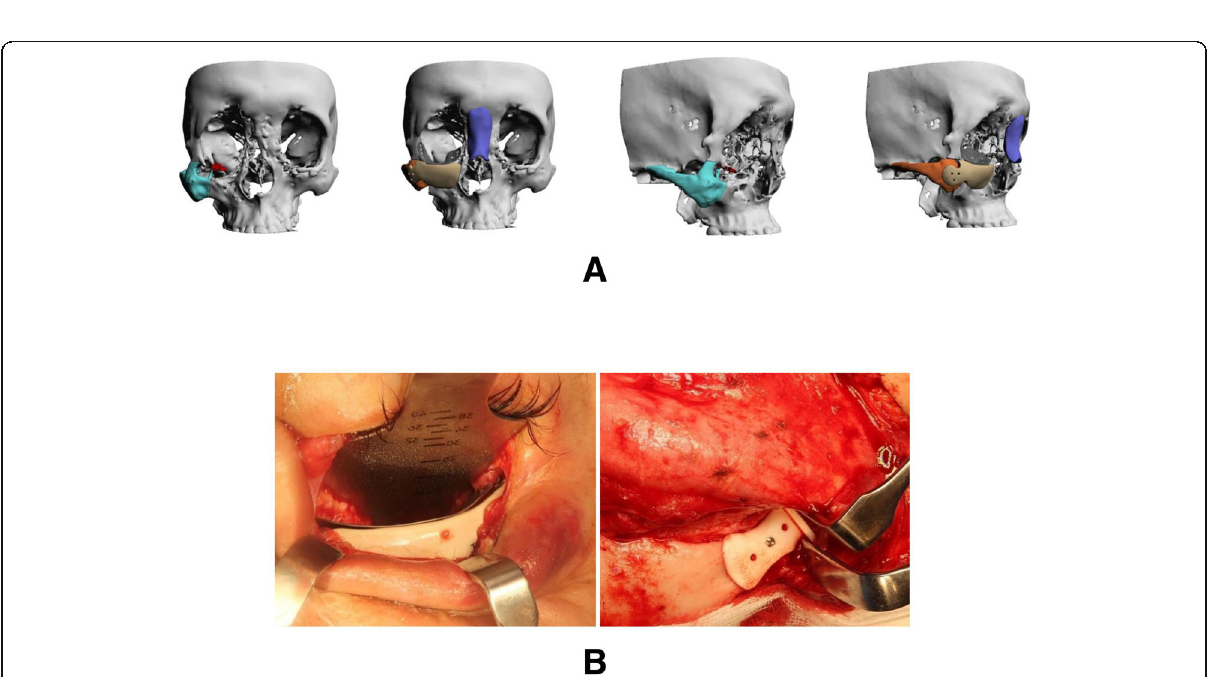
Fig. 5 Post-traumatic defect case. a 3D reconstruction of CT showing defect, original position of zygoma and planned implants, and zygoma repositioning. b Intraoperative views of the